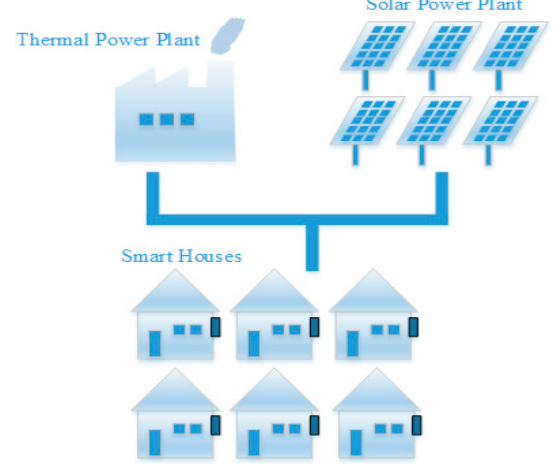
Figure 1. Schematic of the smart grid used in this study.